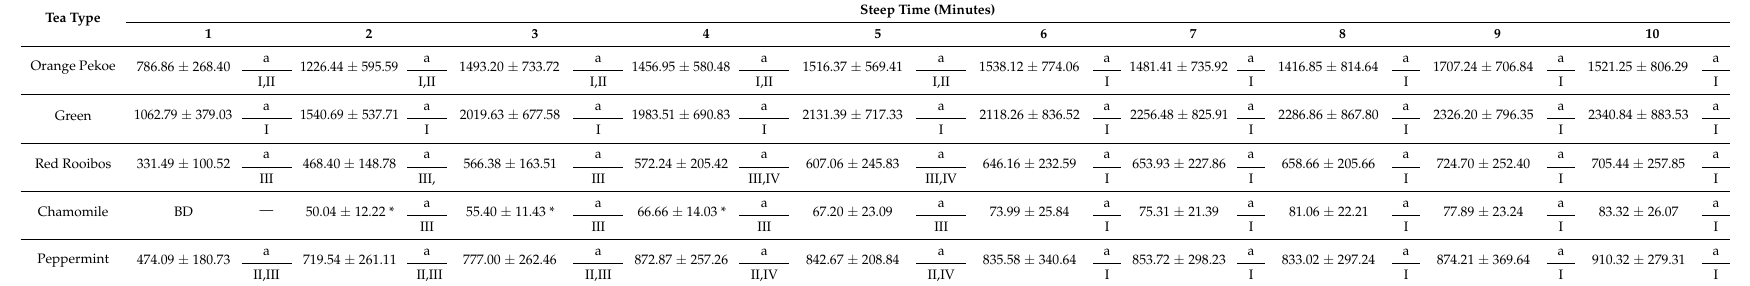
Table A2. Predicted total antioxidant capacity (per gram of tea) measured in black, green, red rooibos, chamomile and peppermint tea bags steeped in distilled water for varying amounts of time. Values are expressed as mean ± SD, n = 6/sample (* denotes groups with n = 4), GAE = Gallic acid equivalents. Columns classified by differing Roman numerals indicate a significant difference ( p < 0.05) in predicted total antioxidant capacity between tea types at a specific steep time. Rows classified by differing letters indicate a significant difference ( p < 0.05) in predicted total antioxidant capacity between time points of a specific tea type. Values below reliable detection using our method are listed as